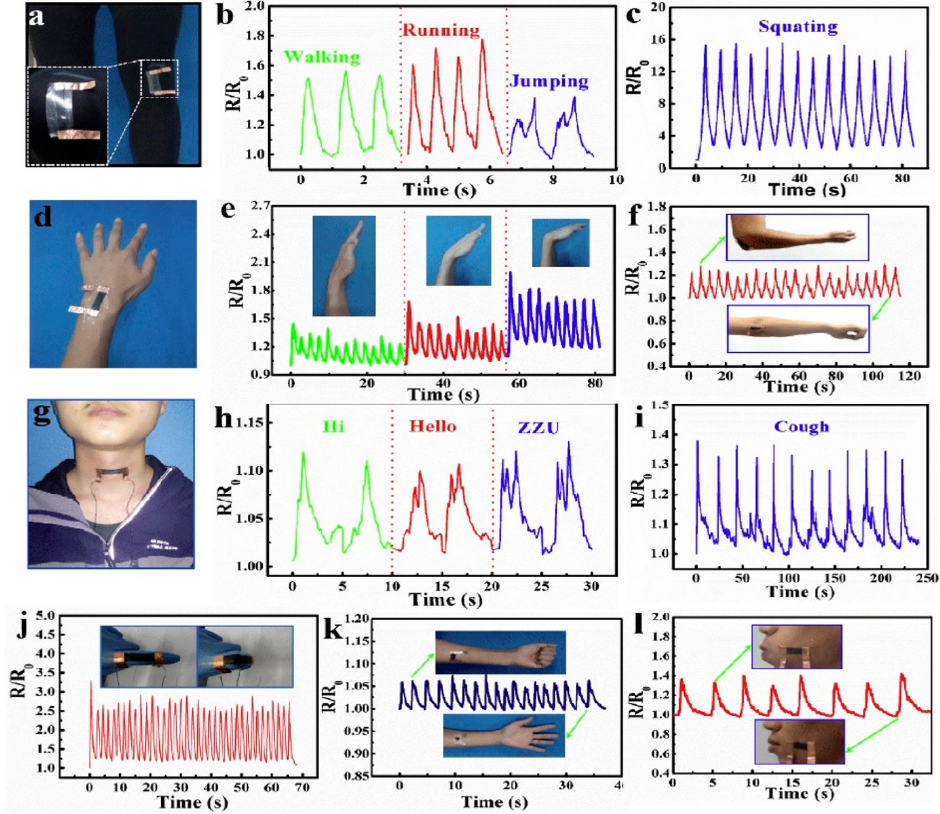
Figure 19. RGO/TPU strain sensors used to detect various human motions. ( a ) Picture of stocking with RGO/TPU strain sensor attached. ( b , c ) Curves of response under motions of walking, running, jumping, and squatting of RGO/TPU strain sensor on the knee. ( d ) Picture of RGO/TPU strain sensor on the wrist of a human. ( e ) Curves of response of diverse bending degrees of RGO/TPU strain sensor on the wrist. ( f ) Curves of response on the elbow under cyclic bending of RGO/TPU strain sensor. ( g ) Picture of RGO/TPU strain sensor attached on the throat. ( h , i ) Curves of response when the wearer coughs and says “Hi”, “Hello”, and “ZZU” (of RGO/TPU strain sensor). ( j – l ) Curves of response of RGO/TPU strain sensor on the finger, arm, and cheek. Reproduced with permission from Ref. [287]. Copyright 2016 the American Chemical